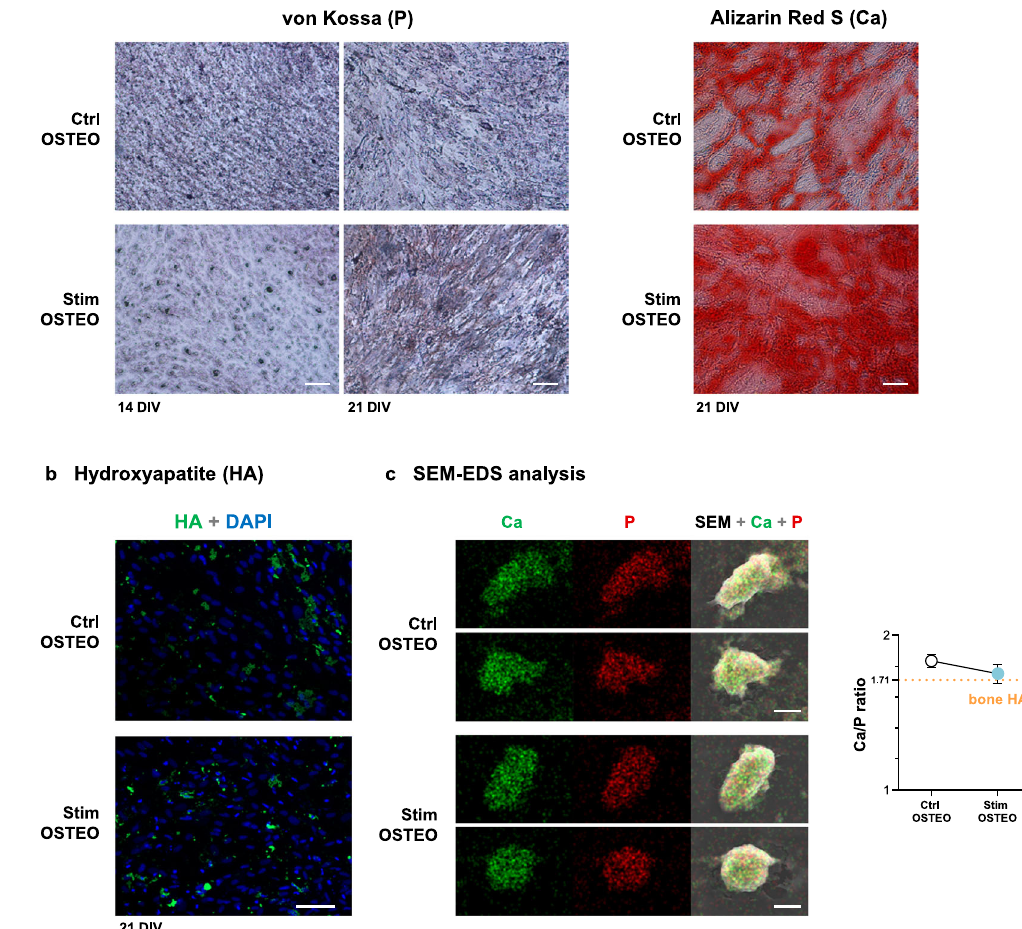
Fig. 6 Effects of high frequency stimulation on hASCs matrix mineralization. a Detection of calcium and phosphate deposits under Ctrl and Stim conditions by von Kossa staining of phosphate nodules upon 14 and 21 DIV and Alizarin Red S (ARS) staining of calcium-rich deposits upon 21 DIV; scale bars, 50 μ m. b Fluorescent staining of hydroxyapatite (HA, green) at 21 DIV. Nuclei were counterstained with DAPI (blue); scale bar, 100 μ m. c Elemental analysis of hASCs extracellular matrices: SEM images and EDS elemental analysis by chemical mapping of calcium (Ca, green) and phosphorous (P, red) at the extracellular matrices of hASCs upon 21 DIV under Ctrl or Stim conditions; scale bar, 6 μ m. The average calcium/phosphate ratios of these hydroxyapatite nodules were calculated using the atomic percentage of each element; the Ca/P ratio of 1.71 is the ratio of HA in natural bone (orange dashed line). Results are presented as mean ± SD ( n =